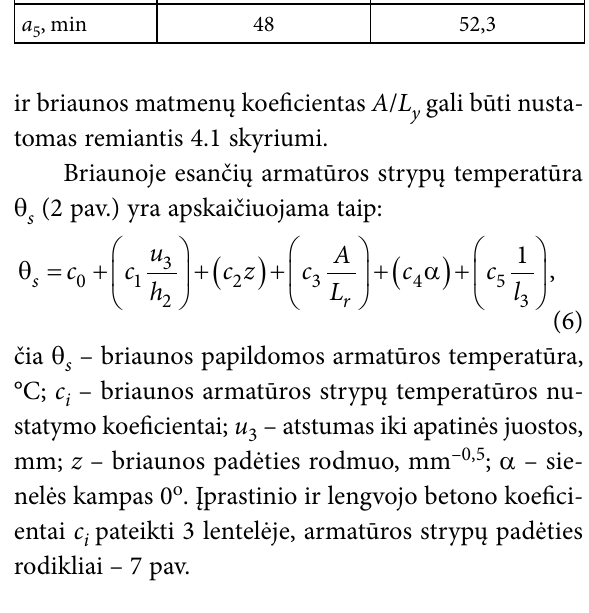
Fig. 6. The edge geometry coefficient A / L